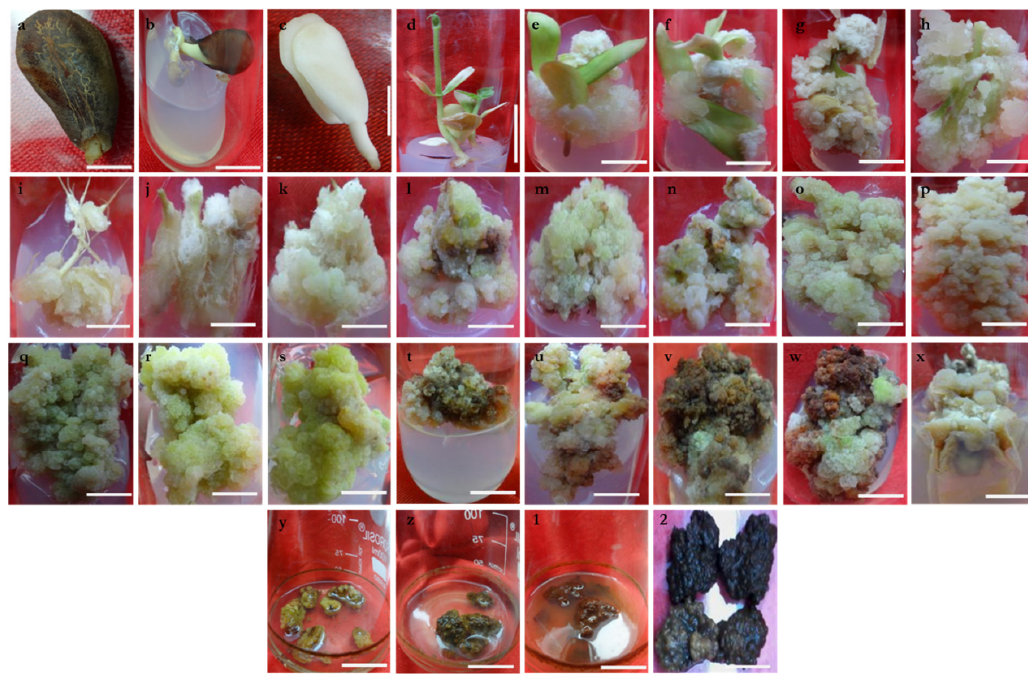
Figure 1. a) Surface sterilized mature seed with a slanted cut at the radicular end; b) In vitro